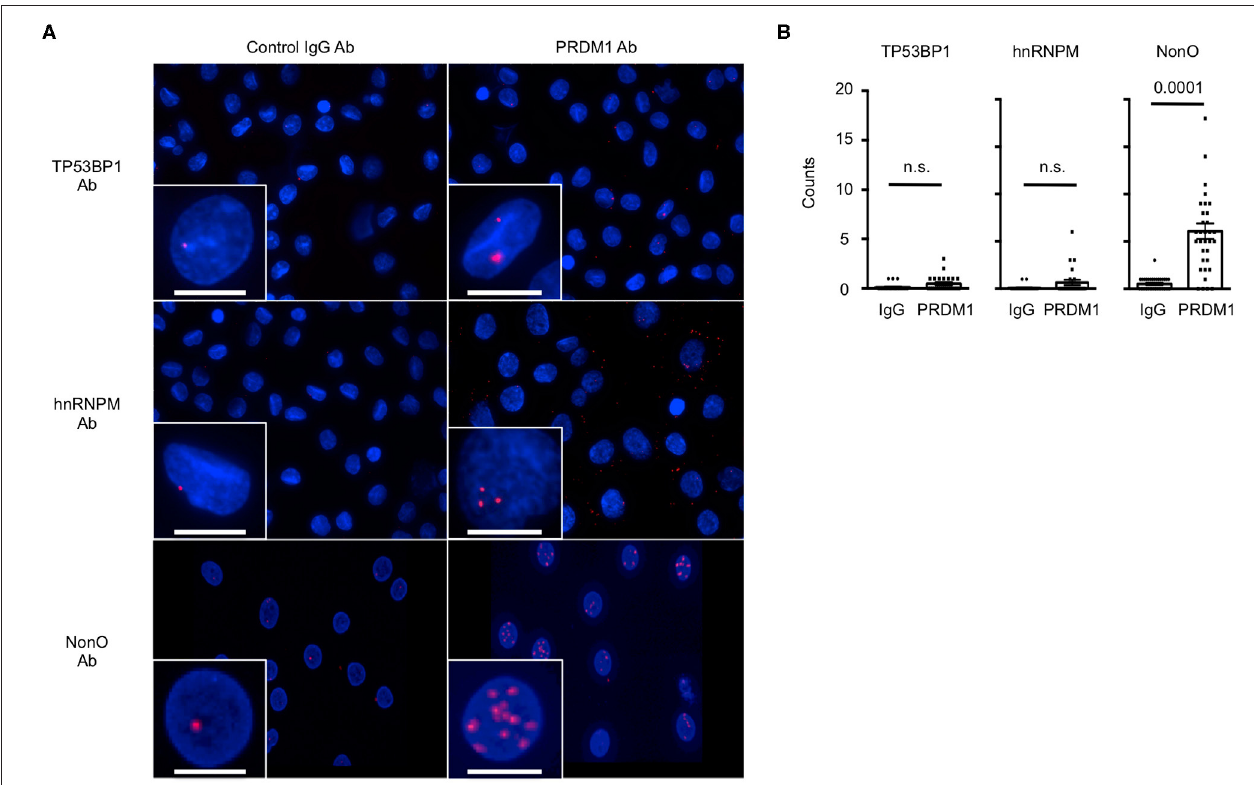
FIGURE 2 | The interaction of NonO and PRDM1 in the nucleus of MO-DCs. Binding of candidate proteins with PRDM1 in primary MO-DCs was measured by PLA. (A) MO-DCs were incubated with normal rabbit IgG (left column) or with anti-PRDM1 antibodies (right column) together with anti-TP53BP1, anti-hnRNPM, or anti-NonO antibodies. Their proximal interaction was assessed by PLA and visualized as red dots. Nucleus was stained with DAPI (blue). Each Z-Stacks maximum intensity projection image is a representative from three independent experiments and captured 60x magnification. Scale bar = 10 µ m. (B) Quantification of the PLA signal on MO-DCs is represented. PLA signals in each nucleus were quantified by Imaris software. In the plot, horizontal bars indicate the mean with SEM and each dot represents counts of individual nucleus ( n = 40–50). Significance determined by unpaired t